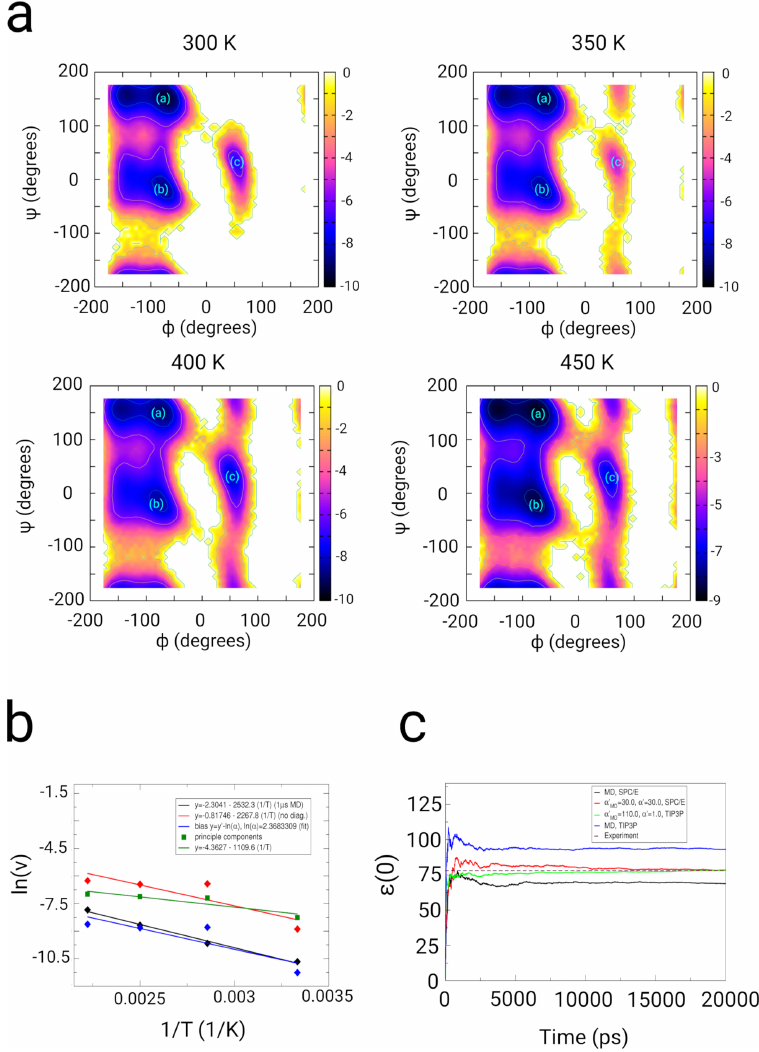
Figure 2. Results from simulations of dialanine peptide in SPC/E water used for the validation of the ( t ) , adaptive bias MD) and ∇ H ( B ) σ sampling along N R multiple biasing increments ∇ H ( B ) ab ( dL ab ik ( L ( t )) , path-sampling) to accelerate the sampling, which results in a biased action integral ( dL σ ik ik L s and a modification of the un-biased Hamiltonian H ( A ) , which results in a hybrid Hamiltonian H ( C ) . ( a ) Free energy landscapes as function of backbone dihedral angles Φ and Ψ from simulations at the temperatures 300 K, 350 K, 400 K, and 450 K using multipe path sampling in combination with optimization techniques (using principal components of the biasing Hamiltonian H ( B ) ), a number = β (cid:48) = 10 − 3 , τ of N R = 10 biases, β (cid:48) 1 = 0.5 ps, and τ 2 = 0.1 ps. Energy values on the color bar md are in units of k B T . ( b ) Comparison of the logarithm of the transition frequency of the dihedral angle Φ as function of the inverse temperature (300–450 K) in the biased (red and green curve) and 1 µ s MD-trajectories (black curve) (blue curve, fit of the biased data to the MD-data for the determination of the linear scaling factor ln( ρ )). In this Kinetic analysis, we determined an acceleration factor ρ equal to 10.68 by which the algorithm accelerates the sampling of dialanine peptide. ( c ) Static permittivities (cid:101) ( 0 ) as function of MD-simulation time using different coupling α (cid:48) and α md -parameters in the individual simulations of SPC/E and TIP3P water compared with conventional MD